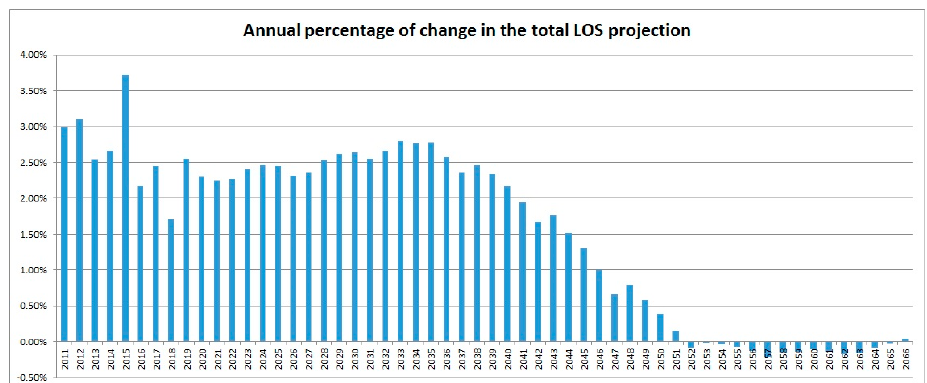
Figure 1. Total days of hospitalisation: 2000–2066. LOS: length of stay.